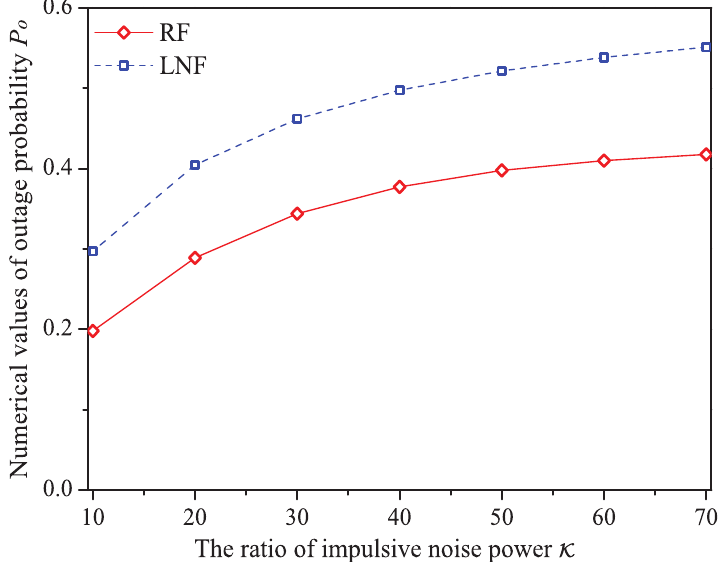
Figure 12. The numerical values of outage probability P o with different K